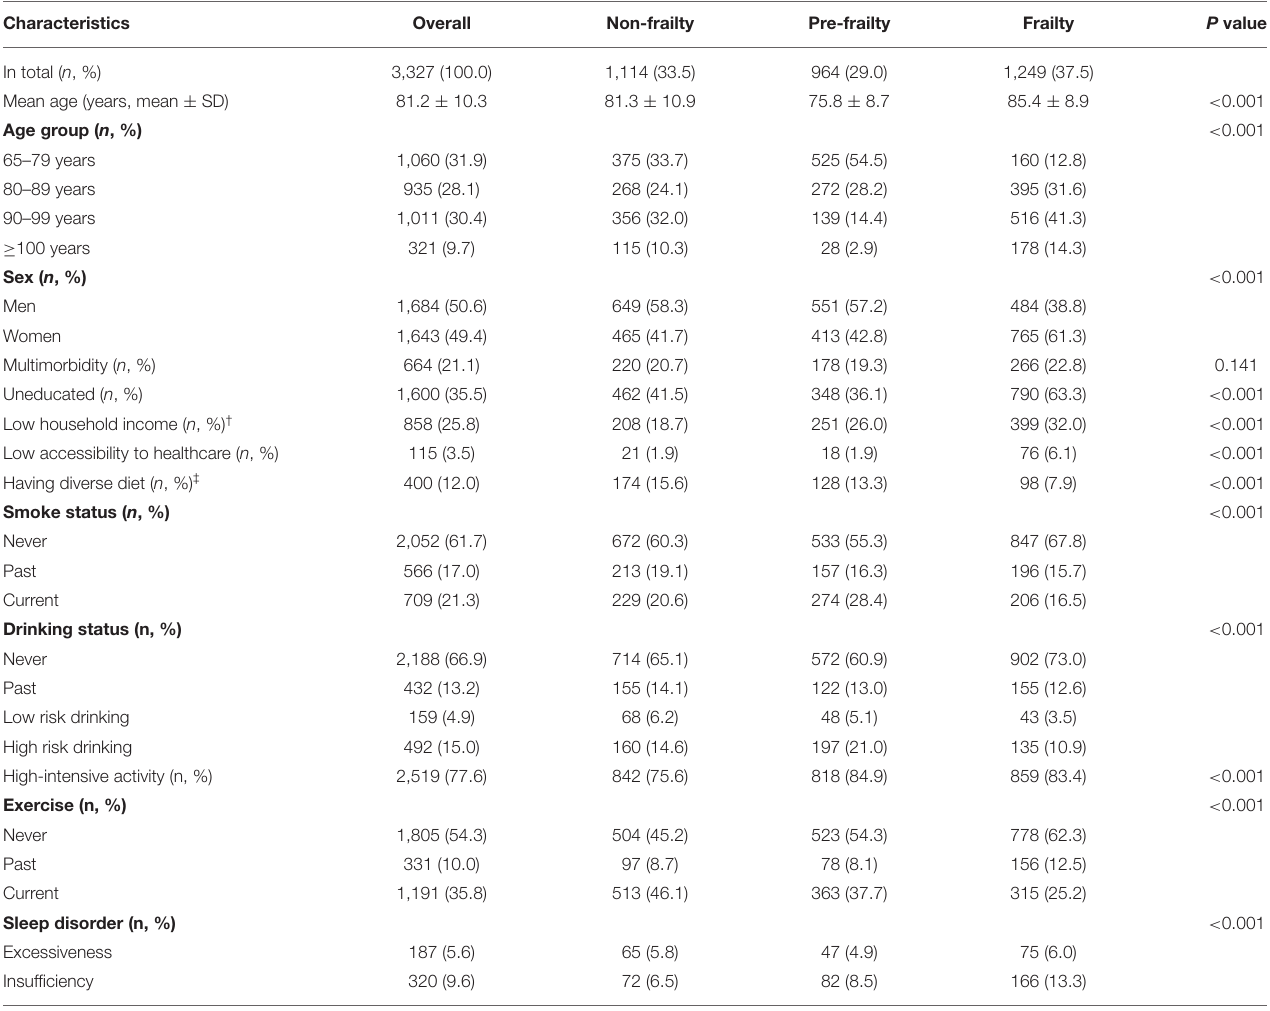
TABLE 1 | Comparison of the characteristics at baseline according to the status of frailty during the follow-up. Characteristics Non-frailty